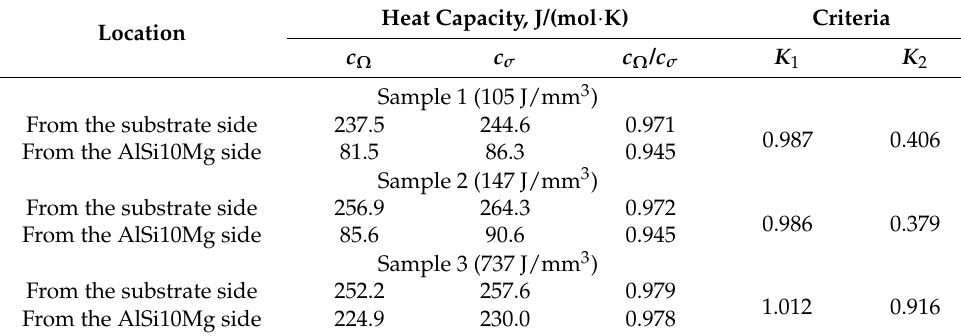
Table 2. Criteria for consolidation at the